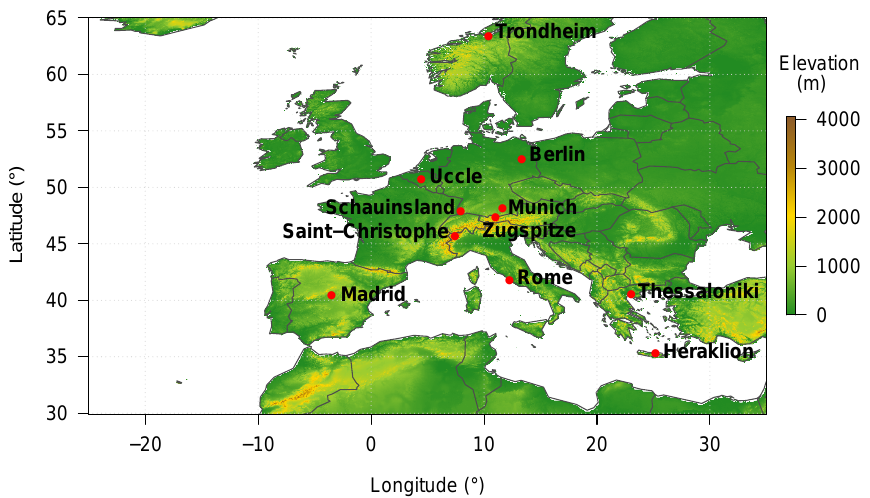
Figure 1. Digital elevation model of Deutscher Wetterdienst for the analysed area of Europe and locations of the selected sites for analysis of satellite-based data (Trondheim, Berlin, Munich, Schauinsland, Rome, Zugspitze, Heraklion, Madrid) and validation with ground-based